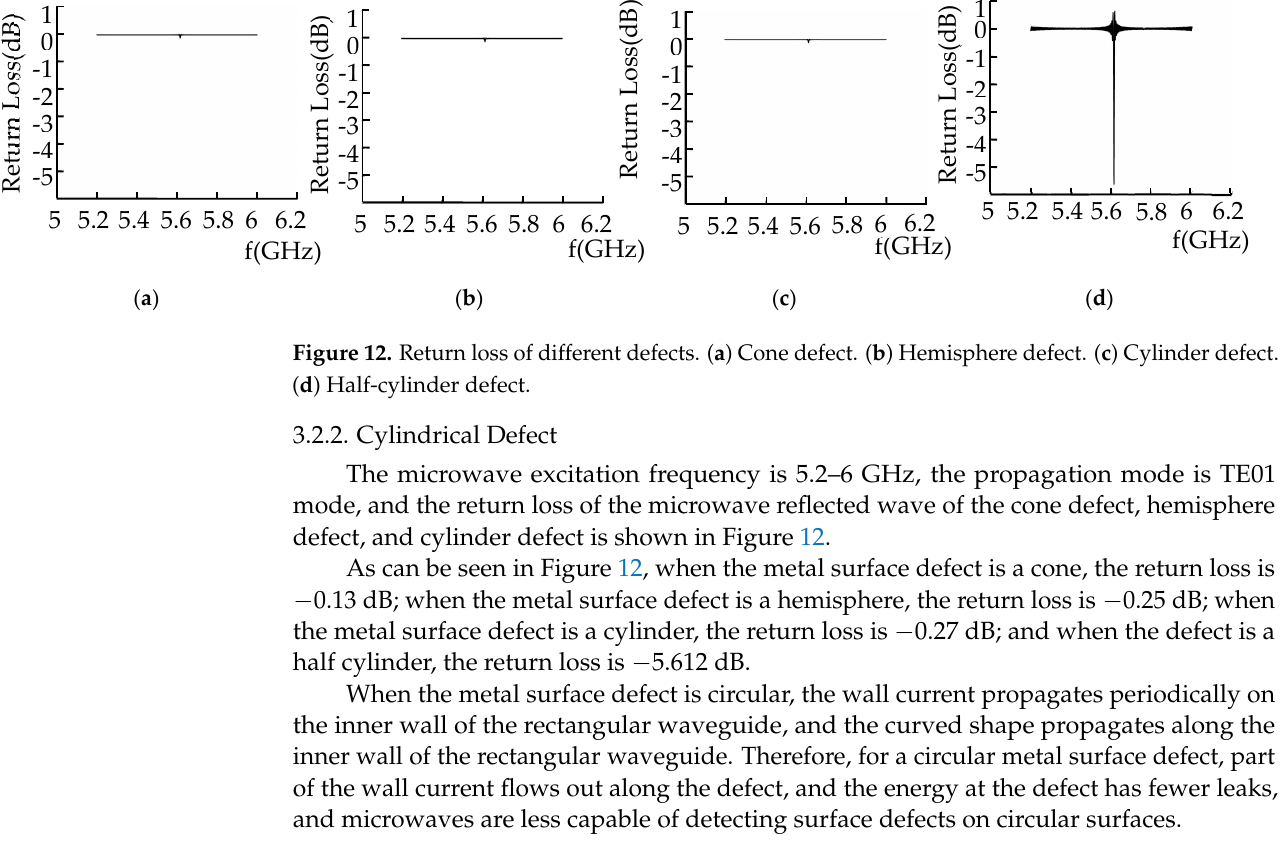
Figure 14. Metal plates with different depths of crack defects. The vector network analyzer transmits and receives microwaves and analyzes the energy loss of microwave reflected waves at the defect. With an increase in defect depth, the return loss of microwave reflected waves under crack defects at different depths is shown in Figure 15. Figure 15. Crack defect signals at different depths. As shown in Figure 15, as the depth of the defect increases, the detection frequency is 5.735 GHz. As the depth of the defect increases, the return loss values are − 3.078, − 4.72, − 5.3, − 5.45, − 6.15, and − 6.2 dB; the energy loss at the defect increases; and the return loss value of the microwave reflected wave at the defect increases. 4.2. TE01 ‐ Mode Microwave Detection of Different Types of Rectangular Defects When the excitation frequency of a TE01 ‐ mode microwave is 5–6 GHz, there are tri ‐ angular ‐ prism defects (20 mm × 10 mm × 5 mm) and trapezoid defects (upper surface, 20 mm × 10 mm; lower surface, 20 mm × 4 mm; and depth, 5 mm) on the body (Figure